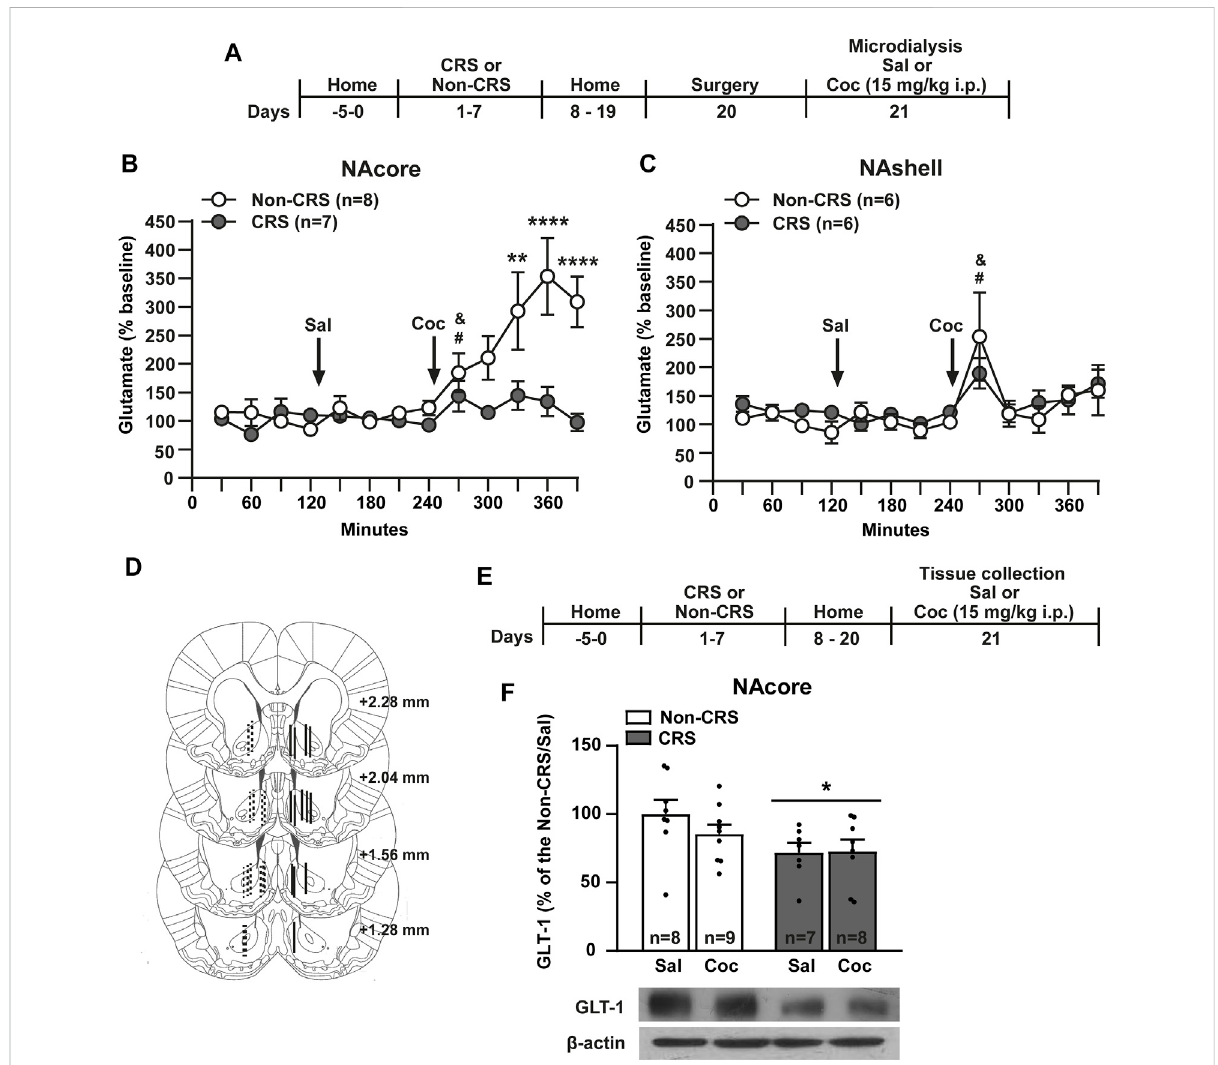
FIGURE 2 Chronic stress exposure induced a blunted glutamate response after a cocaine i. p. injection and a downregulation of GLT-1 in the NAcore. (A) Schematictimelineoftheexperimentalprotocol. (B,C) GlutamatelevelsintheNAcoreandNAshellrespectively.Baseline:measurementsweremade during 120 min. Saline was administered at 120 min, while cocaine (15 mg/kg i.p.) was injected at 240 min. NAcore: Two-way ANOVA with repeated measuresovertimeshowedsigni fi cantinteraction(Non-CRSvs.CRSxtime;F (12,156) =5.04, p < 0.0001),signi fi canteffectofstress(Non-CRSvs. CRS; F (1,13) = 12.47, p < 0.01) and time (F (12,156) = 7.74, p < 0.0001). Bonferroni post-hoc test revealed signi fi cant differences between Non-CRS and CRS after a cocaine i. p. injection at 330 (** p < 0.01), 360 and 390 min (**** p < 0.0001). No differences were found comparing Non-CRS with CRS after a saline i. p. injection (n.s.). The effect of cocaine on glutamate ef fl ux was evaluated in each experimental group comparing results at 240 min (lastdataafterasalinei.p.injection)and270 min( fi rstdatainresponsetoacocainechallenge).Two-tailedunpaired t -testrevealedanacuteeffectof cocaine on glutamate release (Non-CRS: t 14 = 2.29; & p < 0.05 – CRS: t 12 = 2.26; # p < 0.05). NAshell: Two-way ANOVA with repeated measures over time revealed no interaction (Non-CRS vs. CRS x time; F (12,120) = 0.69, n. s.) and no effect of stress (Non-CRS vs. CRS; F (1,10) = 0.29, n.s.) but a signi fi cant main effect of time (F (12,120) = 4.41, p < 0.0001). No differences werefound comparing Non-CRS with CRS after a saline i.p. injection (n.s.). The effect of cocaine on glutamate ef fl ux was evaluated in each experimental group comparing data at 240 min and 270 min. Two-tailed unpaired t -test revealed an acute effect of cocaine on glutamate release (Non-CRS: t p < 0.05 – CRS: t p < 0.05). Two-tailed unpaired 10 = 3.34; & 10 = 2.45; # t -test (Non-CRS vs. CRS) revealed that baseline glutamate levels were not signi fi cantly different between experimental groups either in the NAcore (t 13 = 1.74; p = 0.11) or NAshell (t 10 = 0.15; p = 0.89). However, in the NAcore, but not the NAshell, a marked trend was observed (Baseline glutamate levels – NAcore: Non-CRS = 24.63 ± 10.36 pmol/10 µl, CRS = 76.29 ± 29.61 pmol/10 µl; NAshell: Non-CRS = 34.86 ± 15.31 pmol/10 µl; CRS